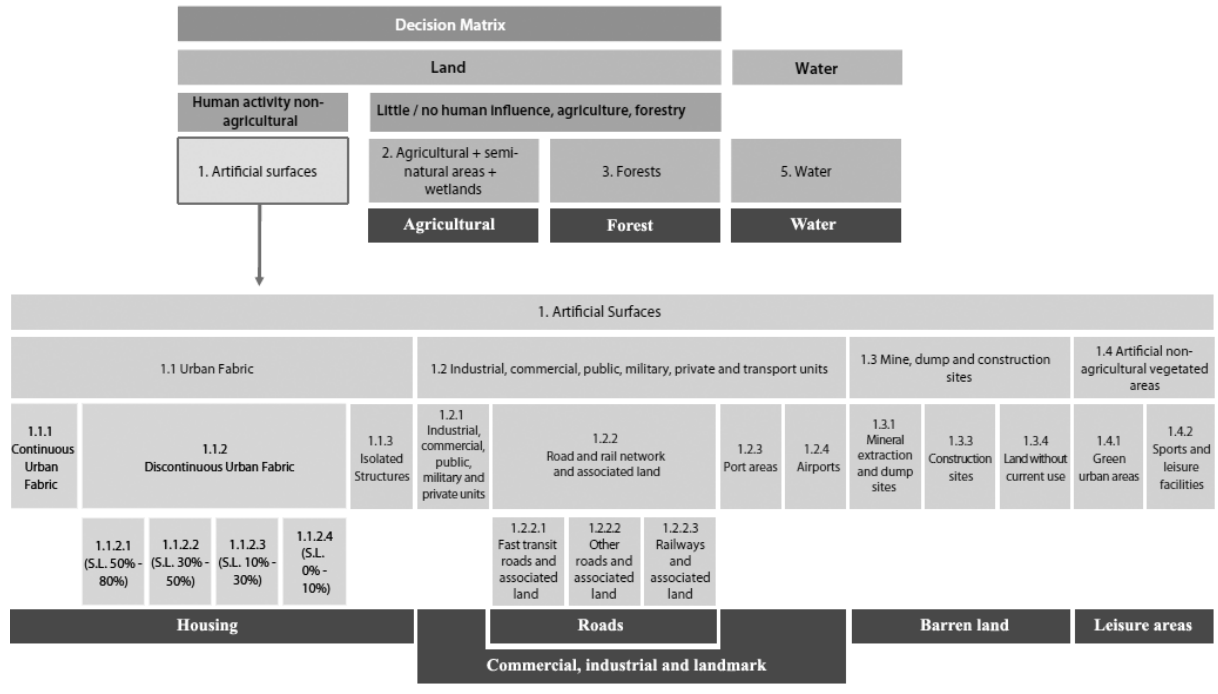
Figure 2. Reclassification of the UA legend into more general classes. Dark boxes represent the new classes. Modified from